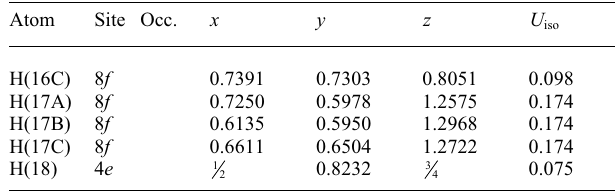
Table 3. Atomic coordinates and displacement parameters (in Å 2 ). Site